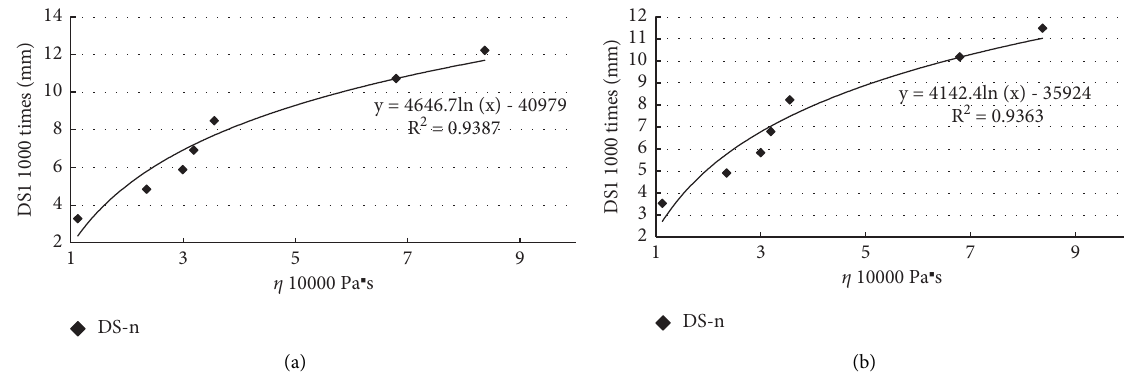
Figure 8: Relationship between DS and modified asphalt. (a) CLWT. (b) APA